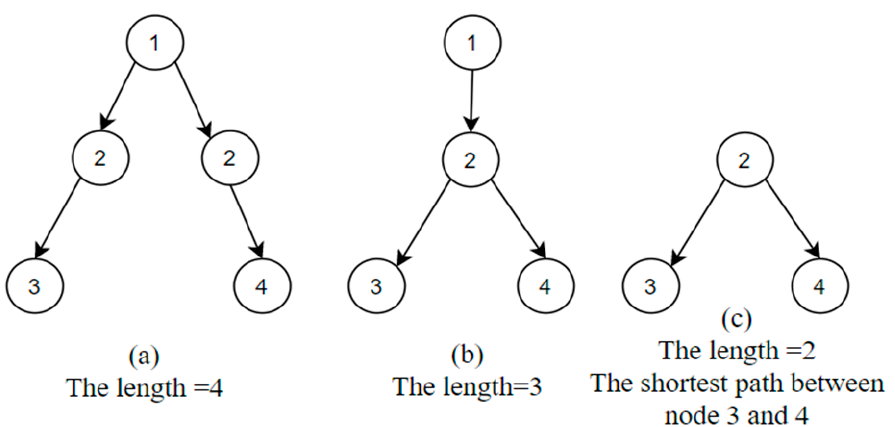
Figure 1. Definitions of the length of paths and the shortest path.